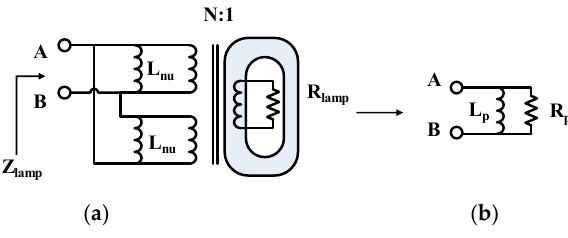
Figure 5. EFL lamp model: ( a ) complete model, and ( b ) simplified model.